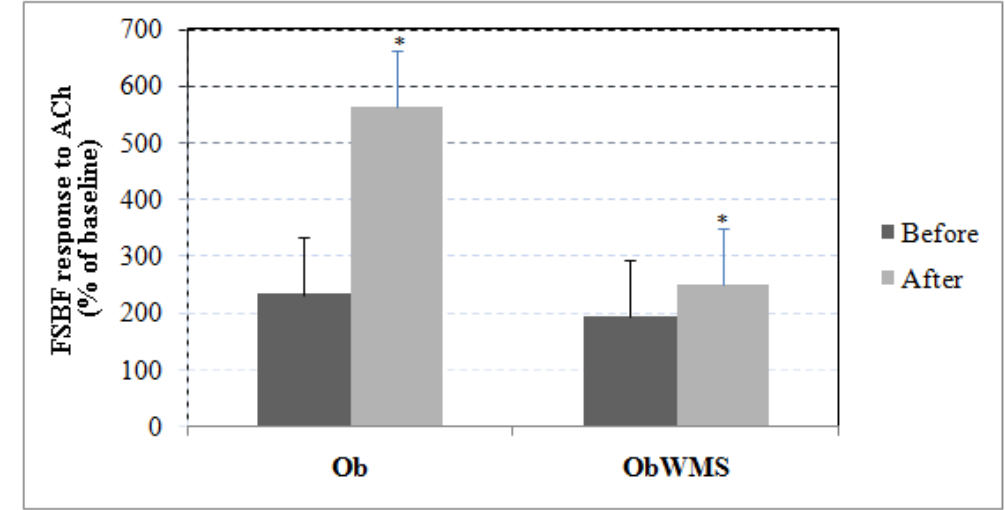
Figure 2. Effects of iontophoresis delivery of Ach on forearm skin blood flow (FSBF) before and after physical training in obese with and without metabolic syndrome. * pre vs. post training at P < 0.001, Ob: obese without metabolic syndrome, ObWMS: obese with metabolic syndrome. However, forearm skin blood flow response to heating the skin at 44 °C, an endothelium-independent vasodilator, remained unchanged in follow-up study in both Ob and ObWMS groups (All; P > 0.05) (Figure 3).